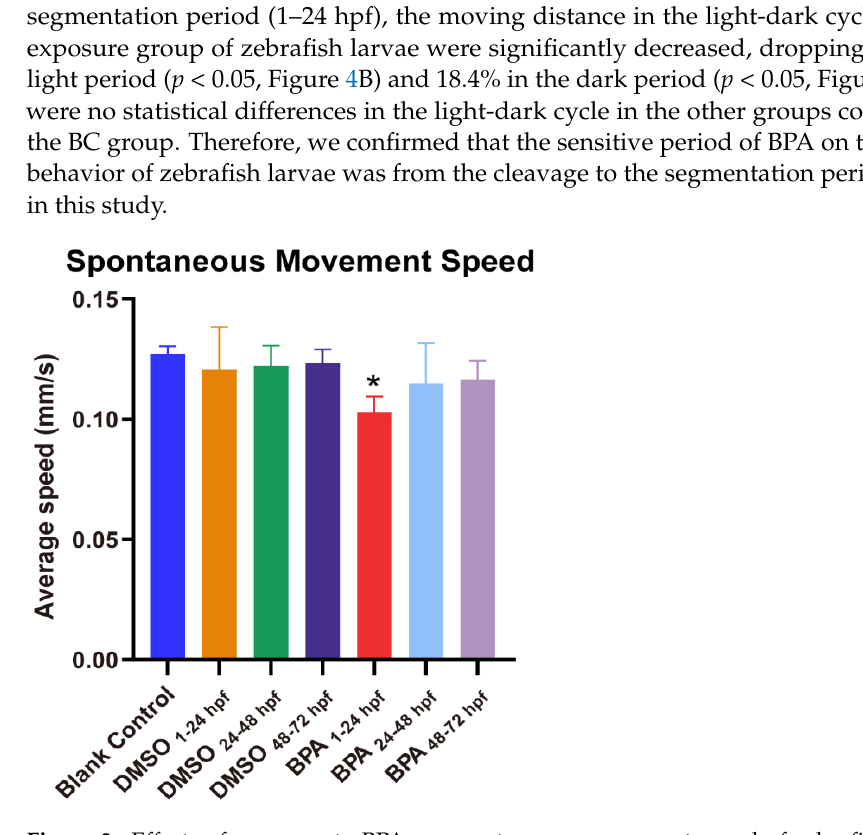
Figure 3. Effects of exposure to BPA on spontaneous movement speed of zebrafish embryos at different developmental periods. Data are the mean ± SD (n = 24 in each concentration). *, significant from blank control, p < 0.05.